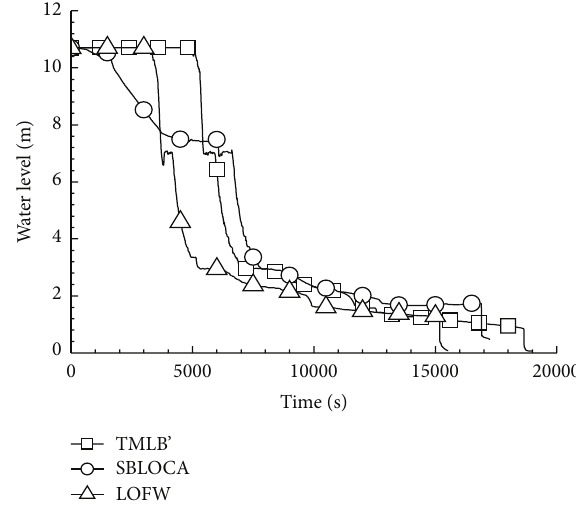
Figure 4: Water level of RPV without activation of